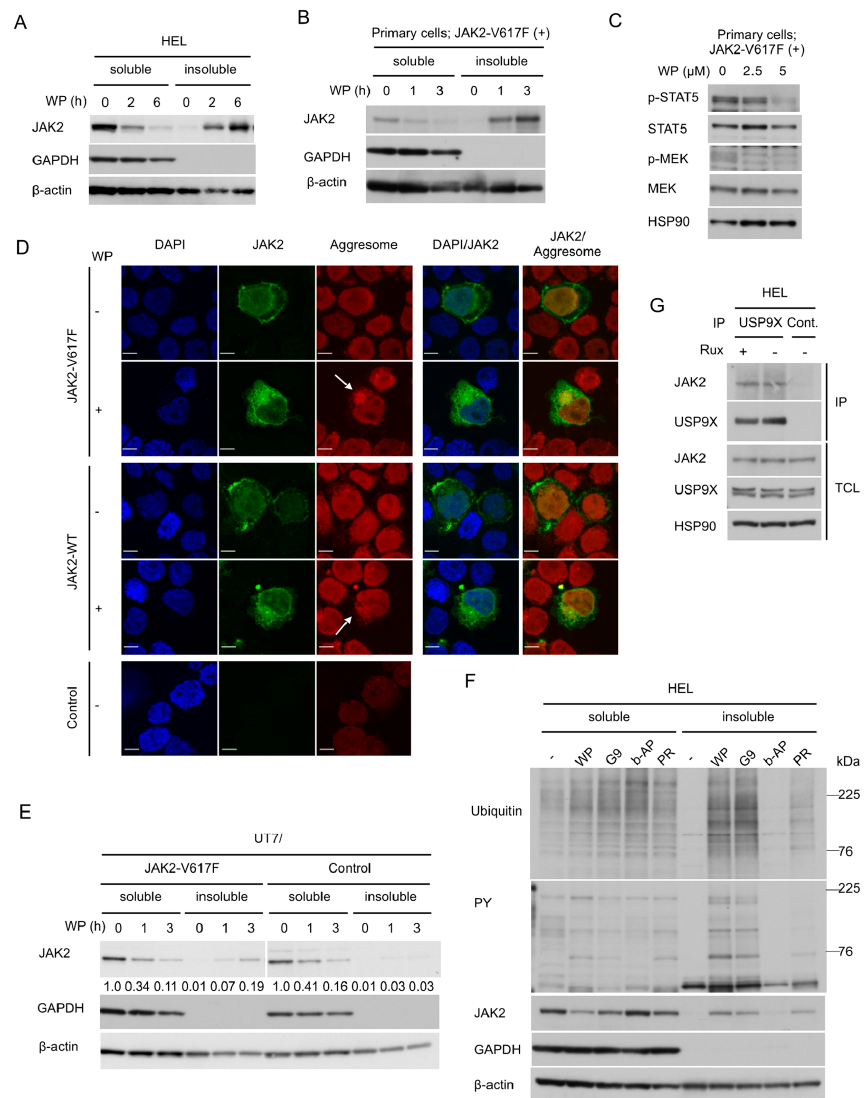
Figure 3. WP1130 induces aggresomal translocation of JAK2 preferentially for the V617F mutant most likely through inhibition of USP9X. ( A , B ) HEL ( A ) or primary post-myeloproliferative neoplasms (MPN) secondary acute myeloid leukemic (sAML) cells expressing JAK2-V617F ( B ) were treated with 5 µ M WP1130 (WP) for indicated times. Cells were lysed and detergent-soluble and –insoluble proteins were extracted and analyzed. GAPDH and β -actin were used for loading controls and confirmation of appropriate fractionation. ( C ) Primary post-MPN sAML cells expressing JAK2-V617F were treated for 2 h with indicated concentrations of WP1130 and analyzed. HSP90 was used for a loading control. ( D ) 293T cells were transfected with plasmids coding for JAK2-V617F, -WT, or empty vector (Control). Cells were left untreated as control or treated with 5 µ M WP1130 for 3 h, followed by processing for confocal microscopy as described in the Materials and Methods. Images represent a 60 × optical zoom with a 3 × digital zoom. DAPI staining shows the position of the nucleus. Representative images of cells are shown. Positions of aggresomes are indicated by arrows. ( E ) UT7 / JAK2-V617F or vector-control cells (Control) were treated with 5 µ M WP1130 for indicated times and analyzed. Relative levels of JAK2 as compared with that in cells not treated with WP1130 were determined by densitometric analyses. ( F ) HEL cells were left untreated as control or treated for 3 h with 5 µ M WP1130, 3 µ M G9, 1 µ M b-AP15, or 25 µ M PR-619, as indicated. Cells were lysed and detergent-soluble and -insoluble protein were extracted and analyzed. ( G) HEL cells were treated for 4 h with or without 2 µ M ruxolitinib (Rux), as indicated. Immunoprecipitates (IP) with anti-USP9X antibody or normal rabbit IgG (Cont.) and total cell lysate (TCL) were